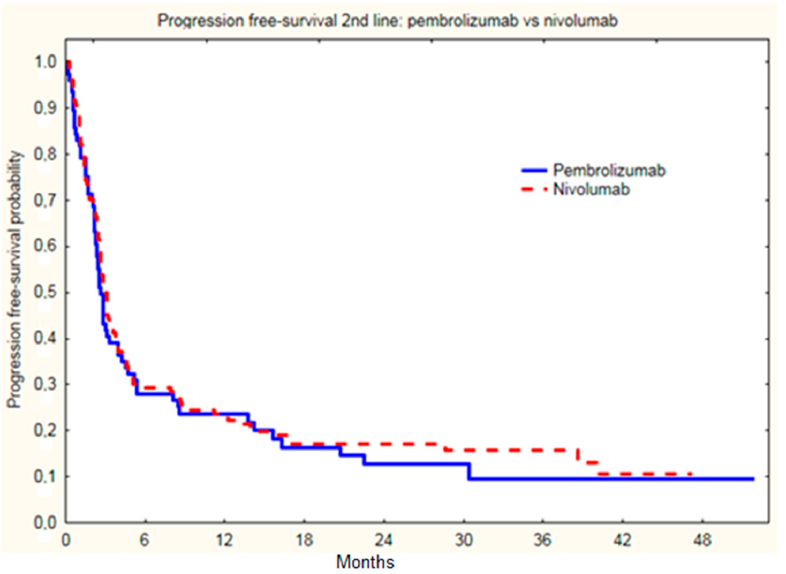
Figure 2. Progression free survival of melanoma patients since initiation of second line nivolumab or pembrolizumab treatment (PSF on nivolumab was 3.0 months, and on pembrolizumab was 2.7 months; p = 0.54).